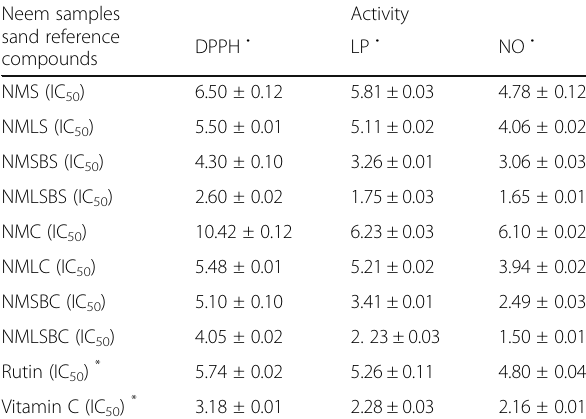
Table 6 Antioxidant capacity of neem cosmetics and reference compounds (mg /